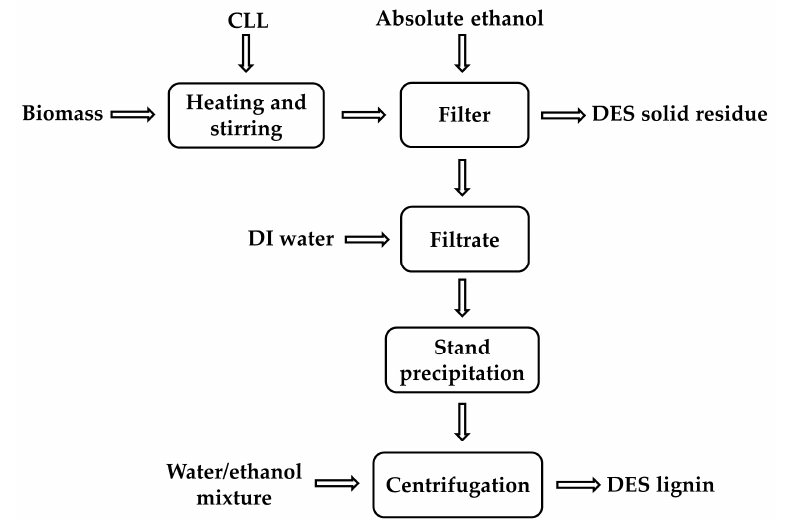
Figure 1. The process of lignin extraction from lignocellulosic biomass by deep eutectic solvent (DES) treatment.